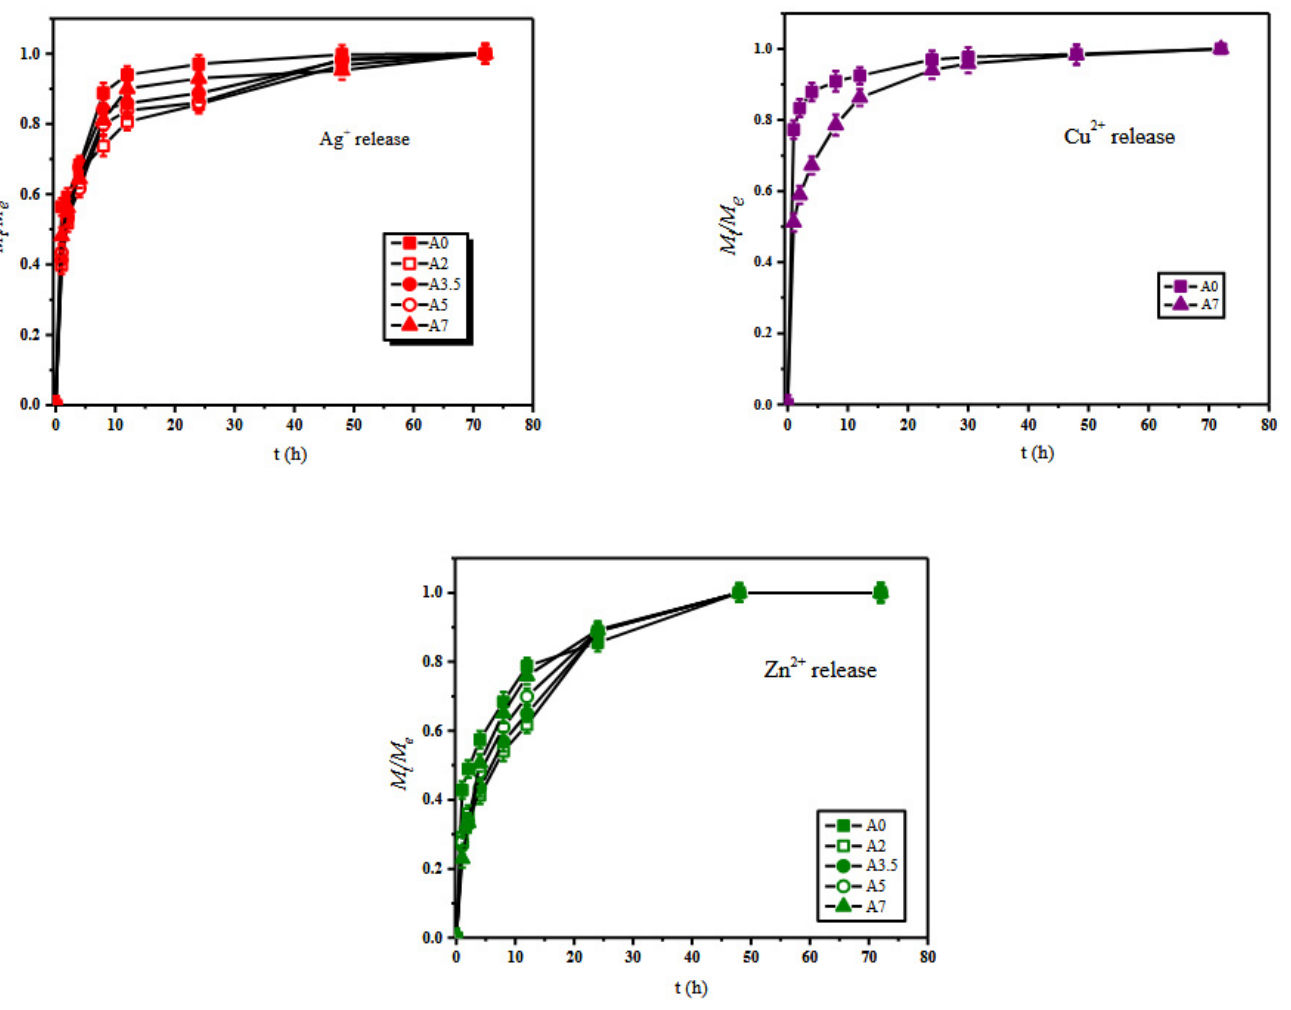
Figure 2. In vitro release profiles of silver, copper and zinc ions from A series hydrogel matrices.